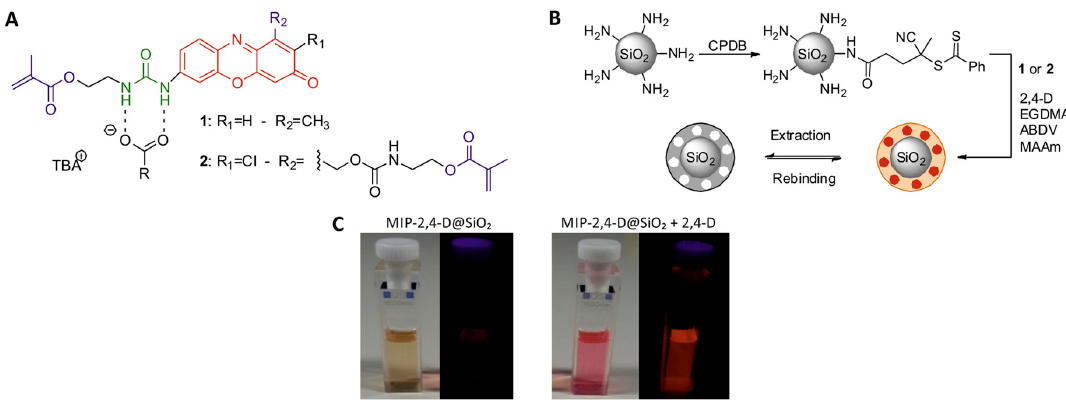
Figure 11. ( A ) Molecular architectures of the phenoxazinone monomer 1 and cross-linker 2. ( B ) Preparation of the core-shell microparticles from amine-modified silica microparticles with imprinting of the template into the MIP shell, followed by extraction and rebinding. ( C ) Photographs of 2 in CHCl 3 in the absence (left) and presence (right) of 2,4-D/TBA in daylight and under UV lamp (365 nm) illumination. Reproduced from [164] with permission of Elsevier.